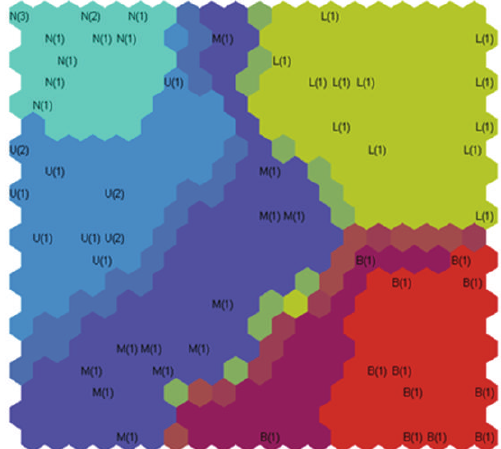
Figure 18: Mapping of RMS vibration.